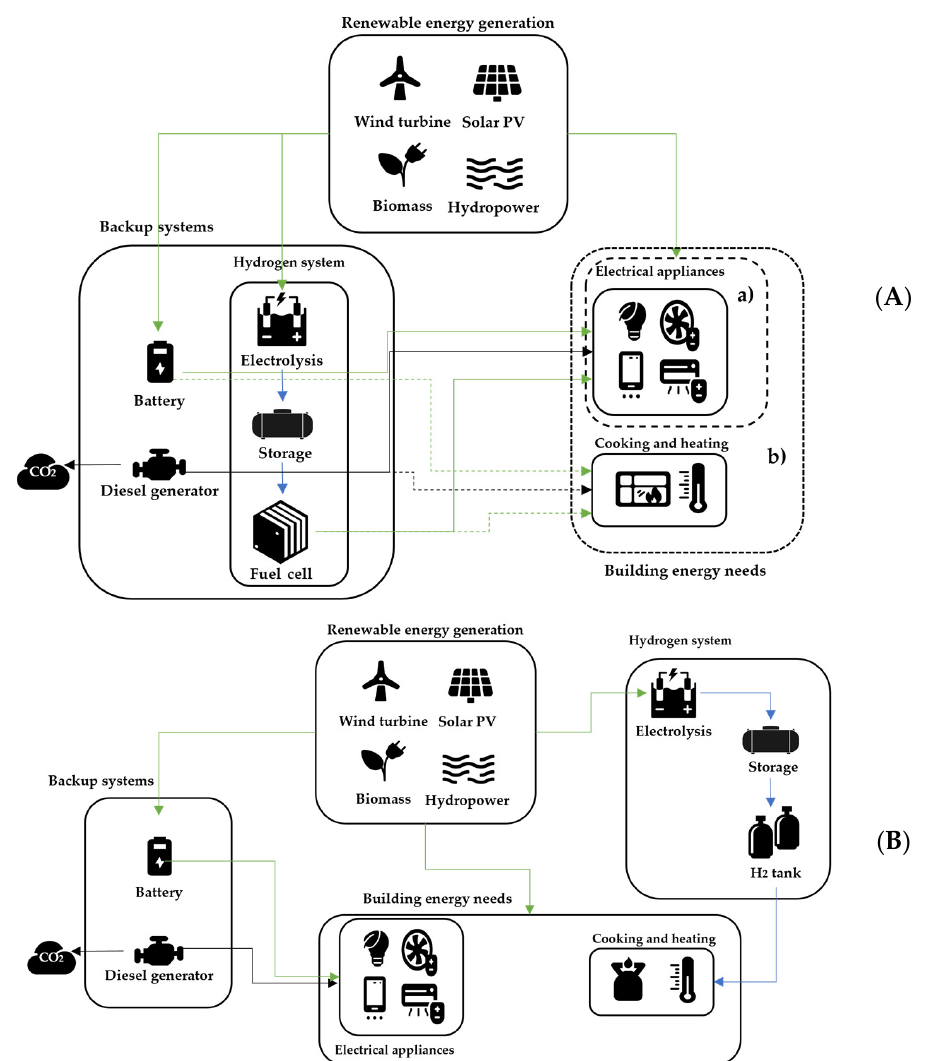
Figure 2. ( A ) Hydrogen integration in an off-grid renewable energy system for electrification of ( a ) lower appliances, and ( b ) additional electric cooking; and ( B ) Separate off-grid power supply and hydrogen cooking via combustion. Notably, the figures neglect the type of current supplied to the loads. Historically, alternating current (AC) loads are more common, however, efficient direct current (DC) loads are becoming more popular. While a DC supply and load is directly compatible with the EL and FC respectively, an AC/DC and DC/AC power converter is required when integrating with AC systems.